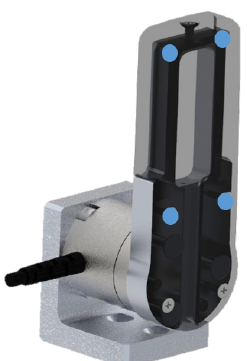
Figure 7. Detail of the gripper custom finger with plastic cover (set transparent), inner metal structure, L-shaped part and F/T sensor. The 4 points for validating the CoP estimation are shown as